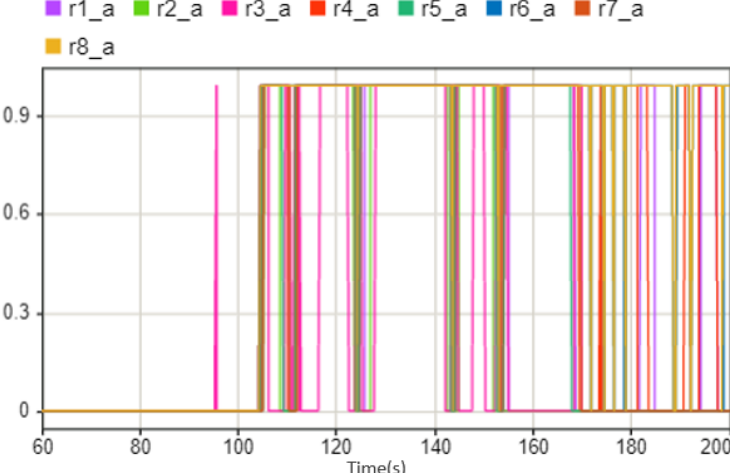
Figure 13. The values of the eight residuals after threshold, this case shows that when steering motor fails between 104 s and 200 s (0 means there is no abnormal situation, 1 means there is an abnormal situation).